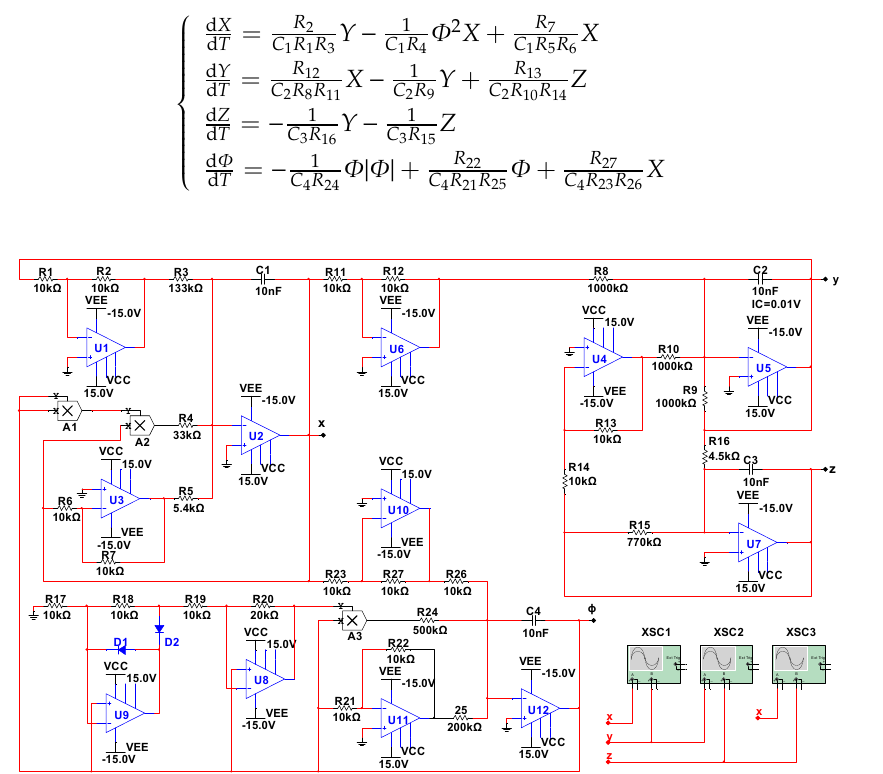
Figure 16. Circuit diagrams of the system.